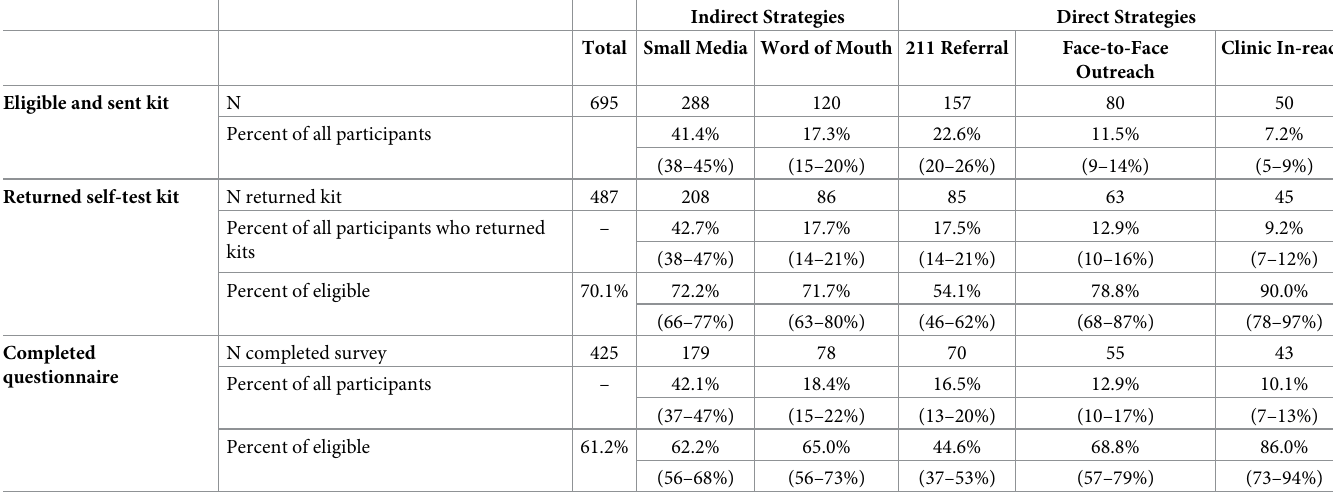
Table 3. Proportion and continued participation of participants, stratified by recruitment source, and indirect versus direct recruitment